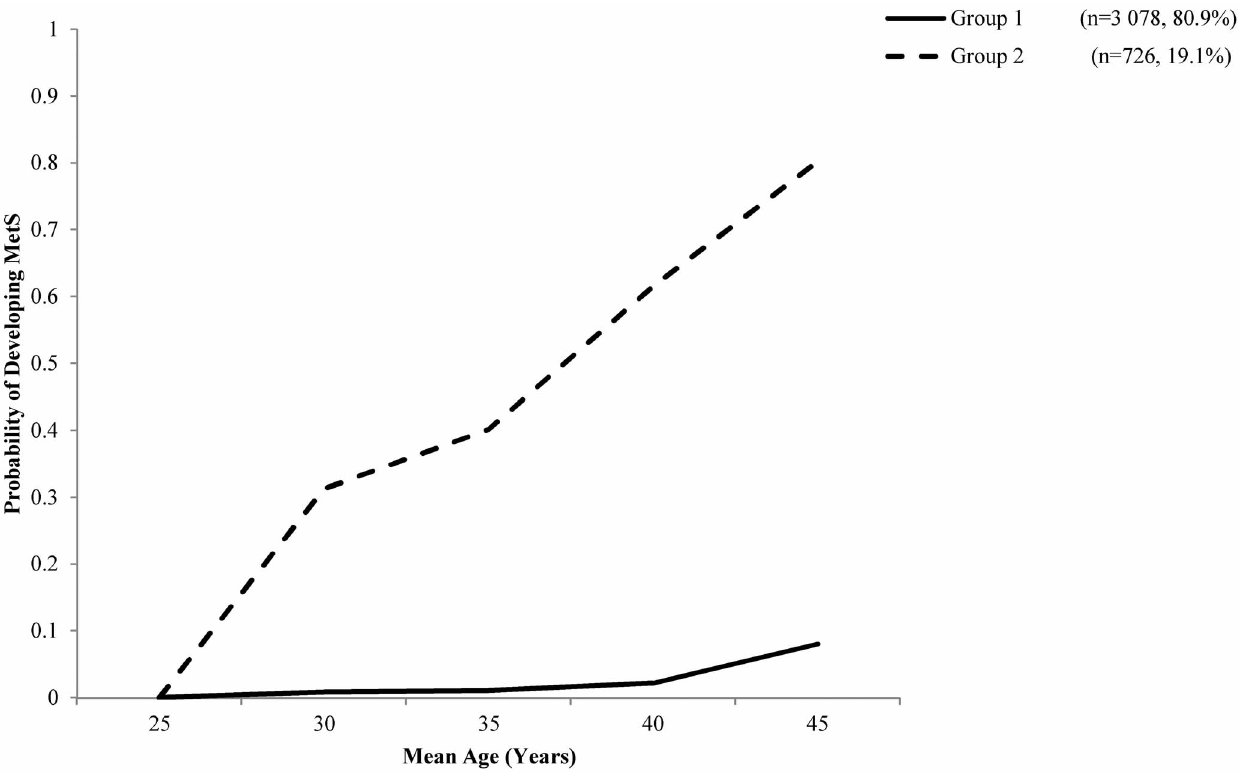
Figure 1. Group-based trajectory of MetS development probability over a 20-year span as determined by PROC TRAJ logit modelling in 3 804 apparently healthy young adults. Two distinct groups were observed and was denoted as Low Probability (n=3 078) and High Probability (n=746).